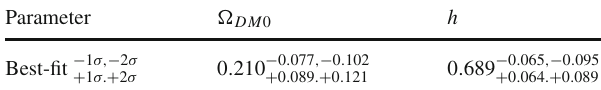
Table 2 The best-fit values with 1 σ and 2 σ errors for (cid:11) mo , h and (cid:11) bo